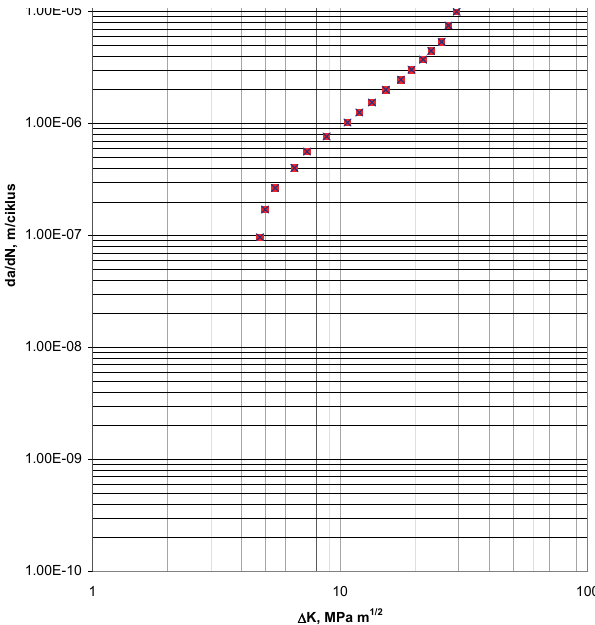
Figure 2: Diagram da/dN-K for specimen PM-2-1e,